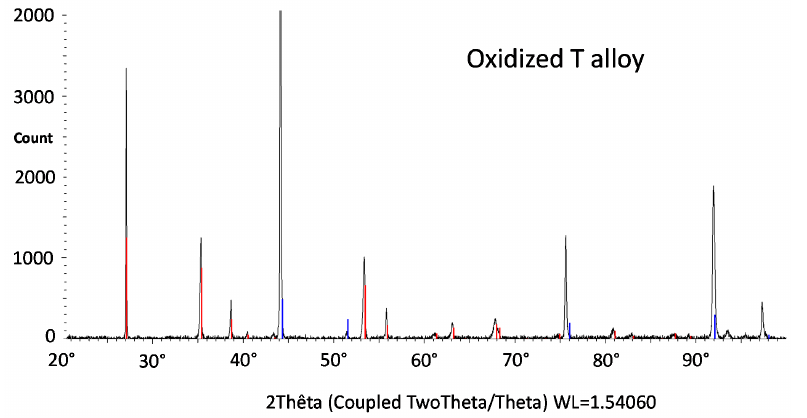
FIGURE 7 Figure 7. XRD spectrum obtained on the oxidized surface of the T alloy (blue peaks: Ni-based matrix, red peaks: CrTaO 4 ).